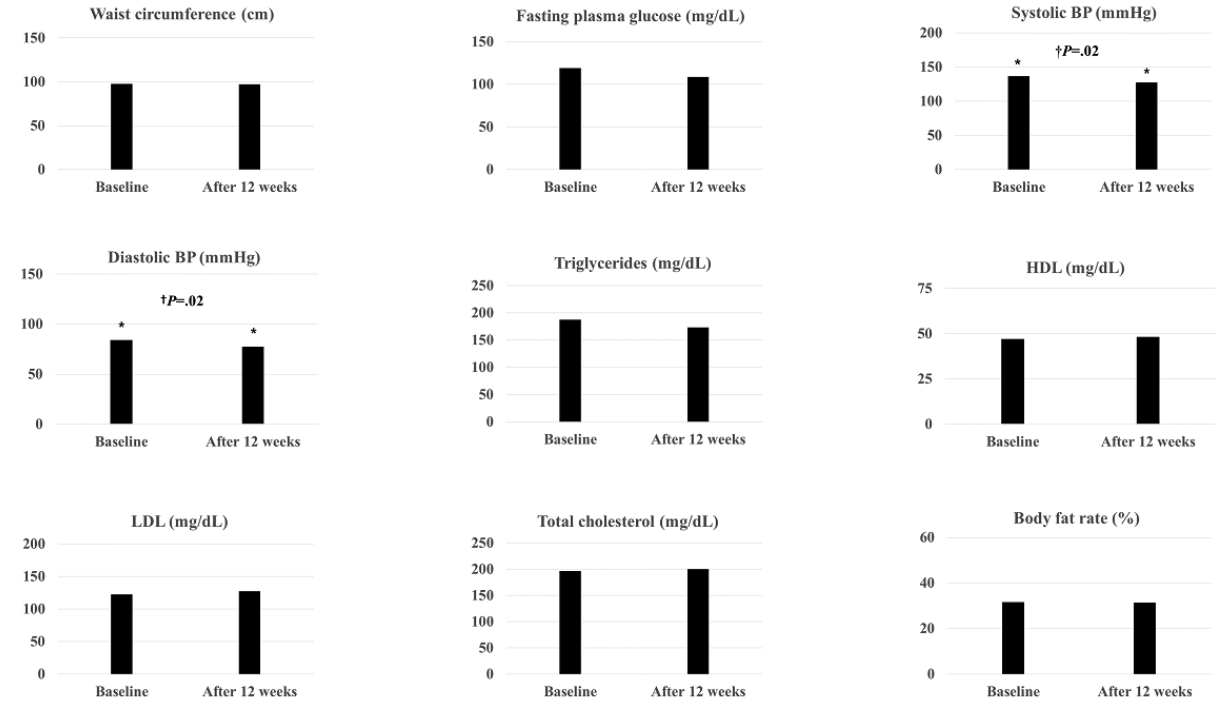
Figure 5. Changes in metabolic components and body compositions after the 12-week intervention. †: Wilcoxon signed-rank test; BP: blood